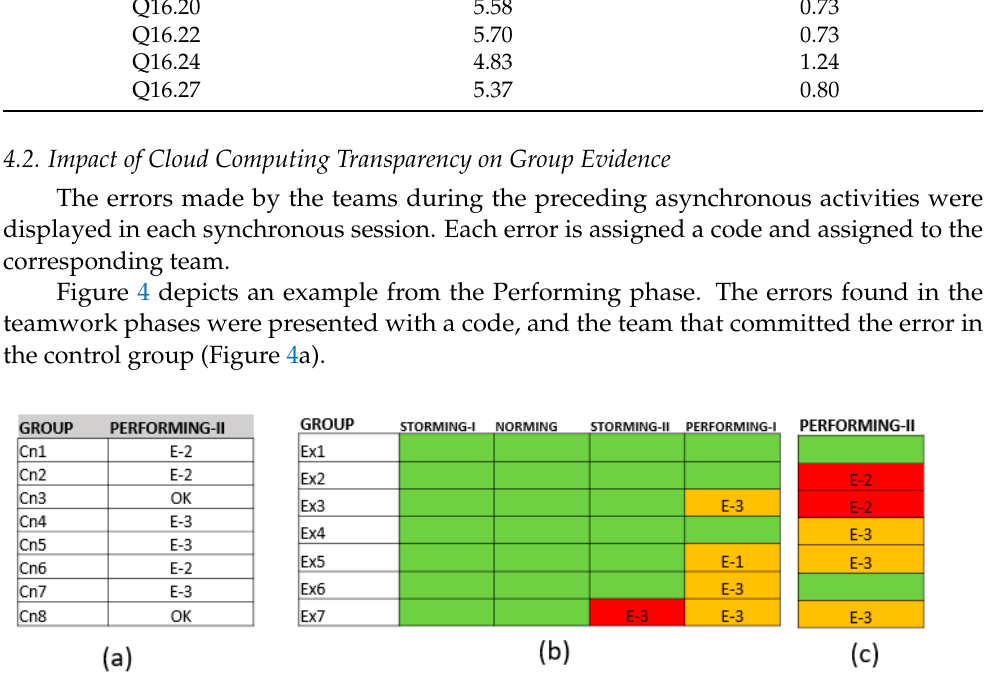
Figure 4. Errors of the teams in the control and experimental groups during the Performing Phase ( a ) Control groups in corresponding phase, ( b ) Experimental groups in previous phases and ( c ) Experimental groups in corresponding phase